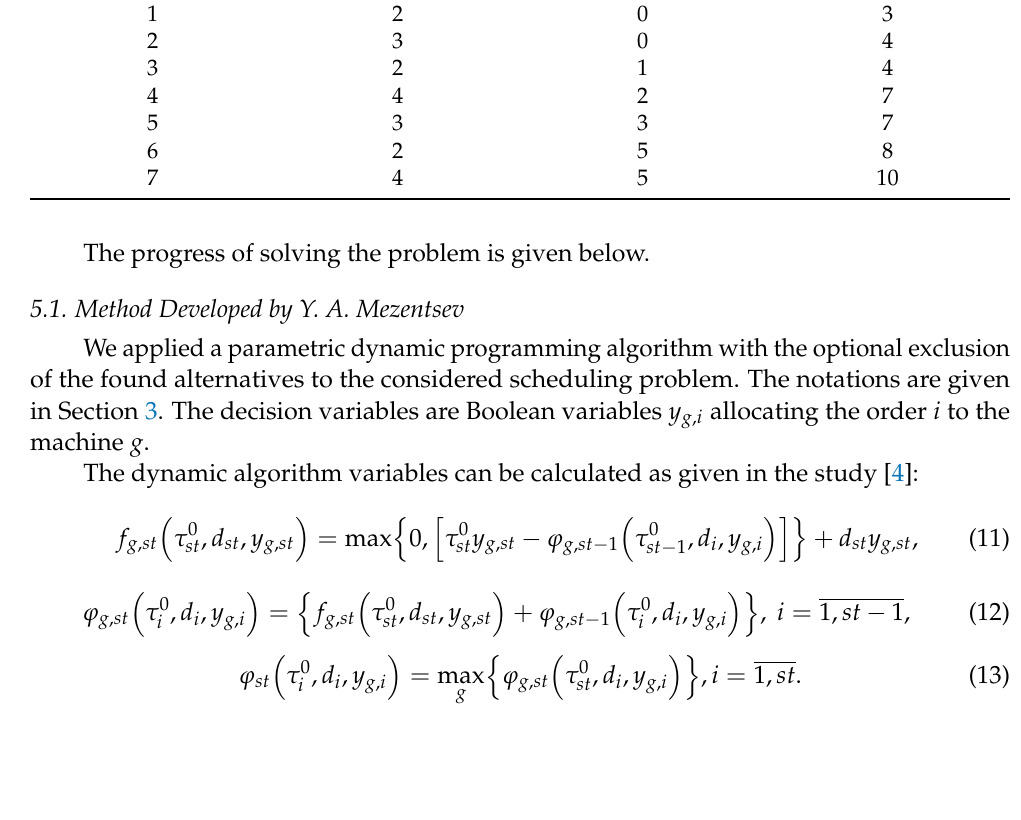
Table 1. Initial information of the trial scheduling problem. Order Number, i Order Duration, d i Earliest Start Time, τ 0 i Deadline, dl